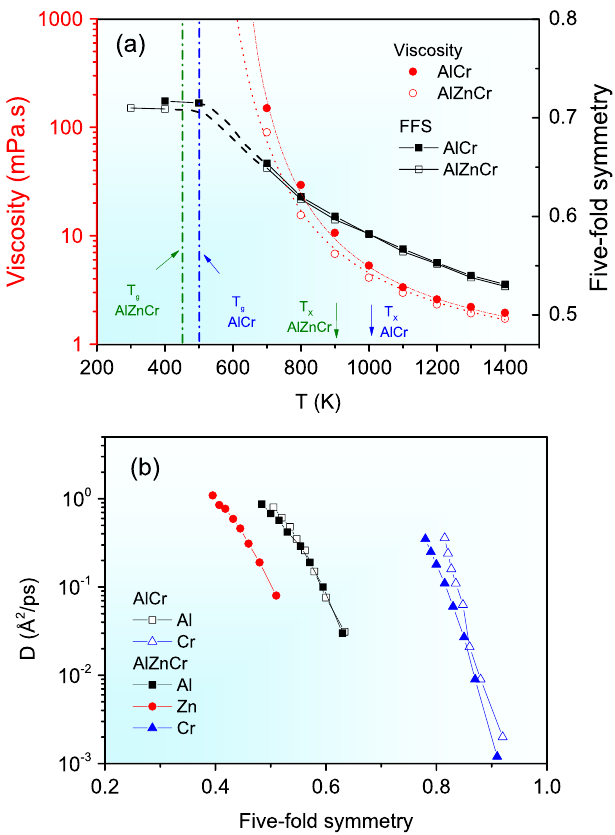
Fig. 8 a Fivefold symmetry (FFS) and viscosity for Al − Cr binary alloy and the Al − Zn − Cr ternary alloy. The dashed - dotted and dashed lines are the respective VFT fi ts. b Self-diffusion coef fi cients as a function of the FFS values for Al and Cr atoms in Al − Cr binary alloy and Al, Zn, and Cr atoms in Al − Zn − Cr ternary alloy